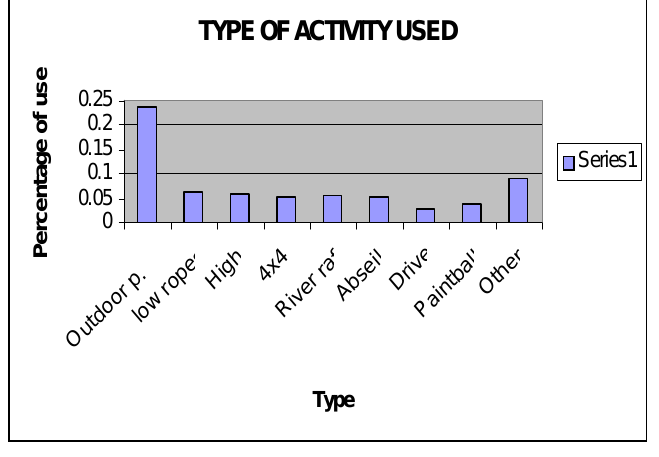
Figure 5: Type of activity used Reasons for intervention